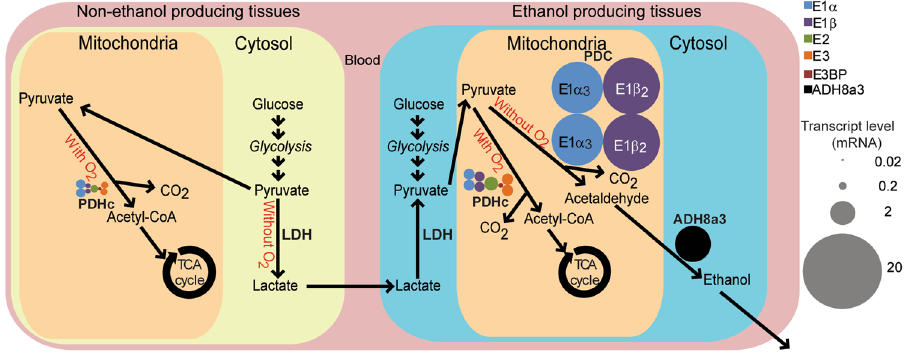
Figure 5. Model for the alternative routes of pyruvate metabolism in Carassius . Model for pyruvate handling in Carassius non-ethanol producing tissues (left), contrasted with pyruvate handling in ethanol producing tissues (right). Combined areas of similarly colored circles correspond to mRNA levels in brain (left) and red skeletal muscle (right) from crucian carp. In case of dimers, total transcript levels were halved, and represented as dimers in the figure, together representing the total transcript level of the corresponding gene. Bubble size is scaled according to mRNA transcript level. In non-ethanol producing tissues, pyruvate from glycolysis is either converted to acetyl-CoA and CO 2 (with oxygen) by the pyruvate dehydrogenase complex (PDHc) or to lactate by lactate dehydrogenase (LDH; without oxygen), as evident from the lack of expressed PDC components. In ethanol producing tissues, pyruvate from glycolysis is either processed to acetyl-CoA and CO 2 by PDHc for further metabolism in the TCA cycle when oxygen is present, or converted into ethanol through the PDC-ADH pathway during